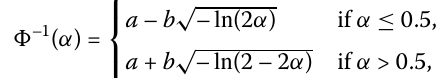
Figure 6 The inverse credibility distribution of ξ ∼ N ( a , b ) in Example 6. The piecewise function (cid:5) –1 ( α ) is the inverse credibility function of ξ ∼ N ( a , b ) whose values are a – b , a , and a + b when α are 1 e –1 , 0.5, and 1 – 1 e –1 , 2 2